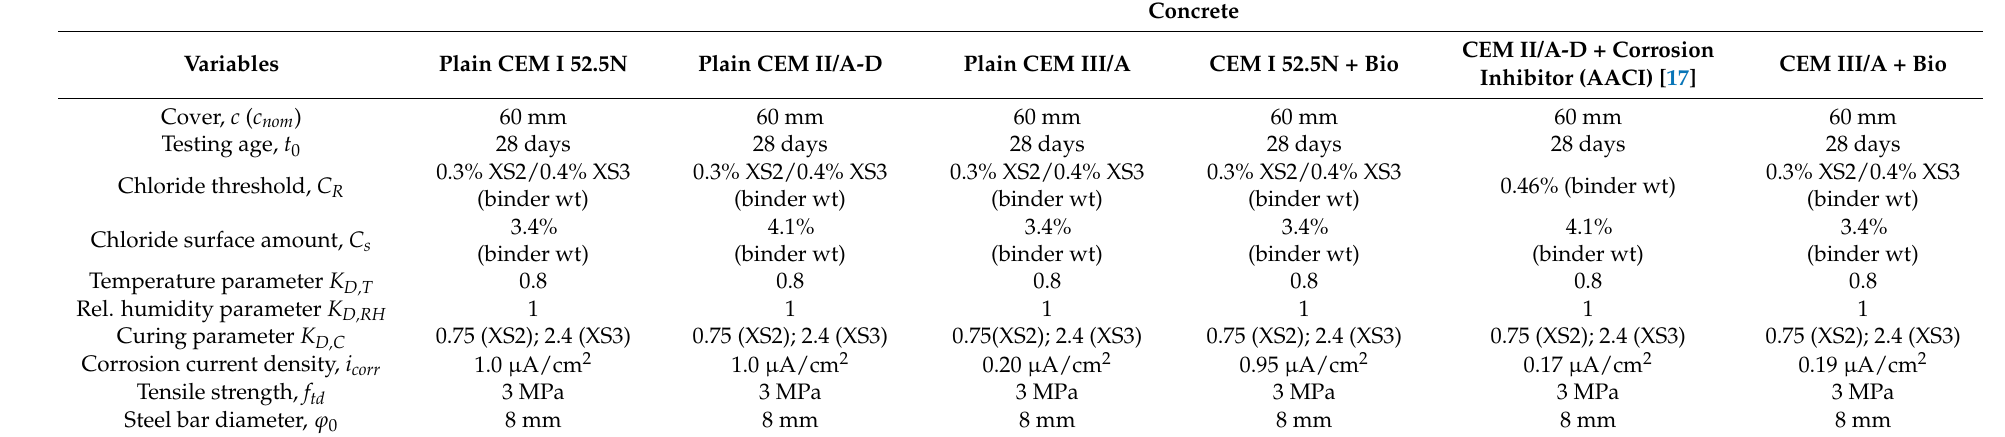
Table 3. Chlorides class and XS2 (submerged) and XS3 (tidal/splash)—calculus variables.